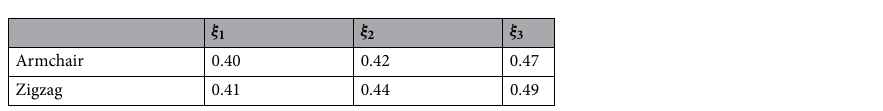
Table 1. Conversion factors for the first three subbands calculated from the transconductance (Fig. 6) with NO